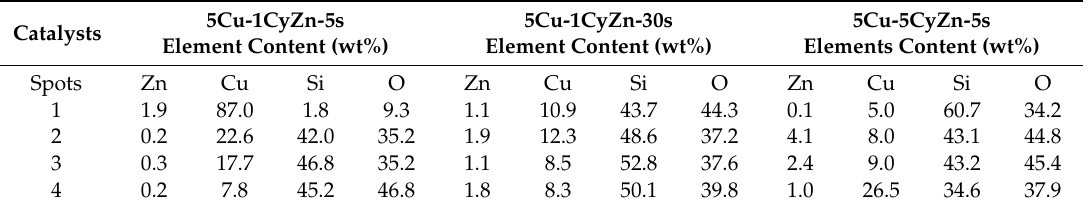
Table 2. The content of elements on the reduced ZnO over-coated Cu / SiO 2 catalysts detected by TEM-EDX.